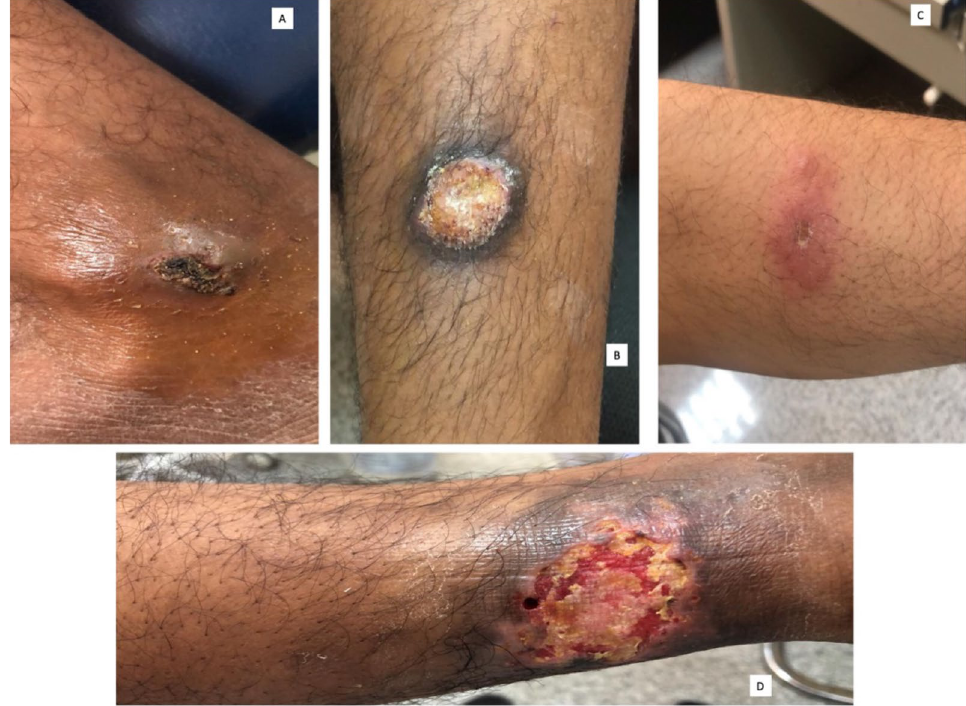
Figure 5. Different skin manifestations of CL patients. A: Right leg nodular lesion (1.5–2 cm) in a 43-year-old male laborer; B: Right leg ulcerative plaque lesion (4 cm) in a 37-year-old male farmer; C: Left forearm plaque lesion (0.5–1 cm) in a 48-year-old male truck driver; D: Left leg ulcerative lesion (5–5.5 cm) in a 31-year-old male